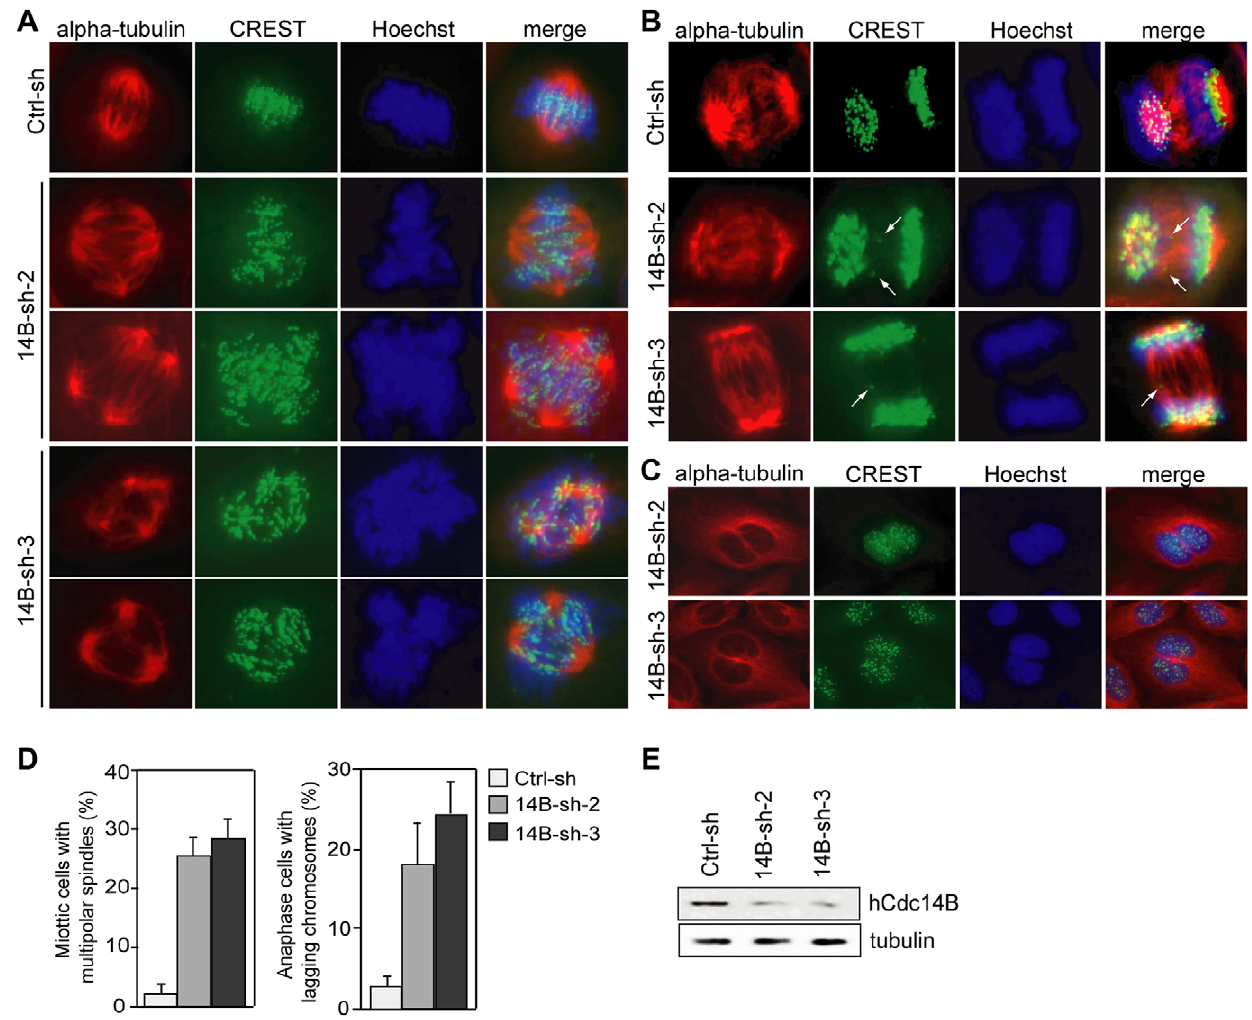
Figure 4. Downregulation of hCdc14B leads to multipolar mitotic spindles, lagging chromosomes, and binucleation. U2OS cells were transfected with pTER plasmids expressing two different hCdc14B-specific shRNAs (14B-sh-2, 14B-sh-3) or a control shRNA (Ctrl-sh). 72 h after transfection, cells were processed for immunofluorescence using anti-alpha-tubulin and Cy3-coupled anti-mouse antibodies (red), and CREST antiserum (kinetochores) and FITC-coupled anti-human antibodies (green). DNA was stained with Hoechst 33342. Representative examples of multipolar mitotic cells ( A ), bipolar mitotic cells with lagging anaphase chromosomes (arrow) ( B ), and binucleated cells ( C ) are shown. D . Frequencies of multipolar spindles and lagging anaphase chromosomes as visualized by staining with anti-alpha-tubulin and CREST. The numbers are derived from three independent experiments, each count comprising 60 mitotic cells. E . Western blot of hCdc14B after transfection with pTER-ctrl-shRNA (Ctrl-sh), pTER-Cdc14B-2 (14B-sh-2), and pTER-Cdc14B-3 (14B-sh-3) for 72 h. Decrease of hCdc14B expression was normalized to b -tubulin.